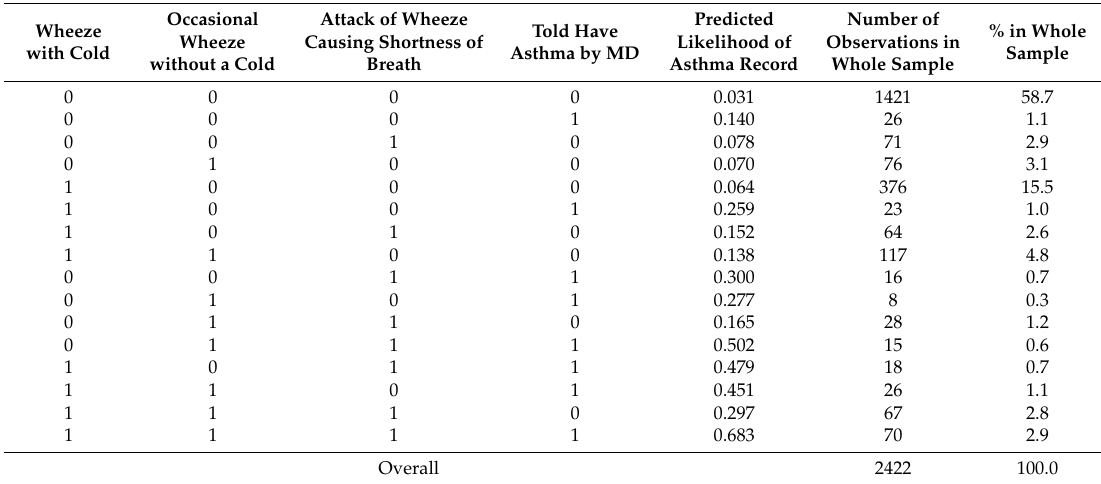
Table 4. Predicted likelihood of asthma record in administrative health records calculated for each combination of symptoms from the self-report questionnaire ( N = 2422).